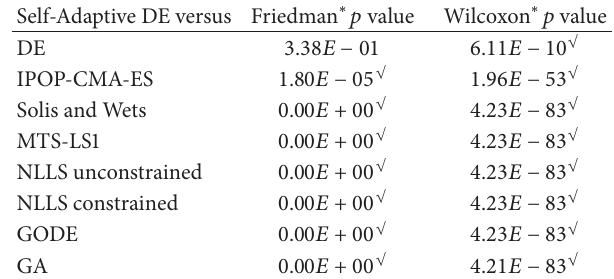
Table 16: Corrected 𝑝 values according to Holm’s method (Self- Adaptive DE is the control algorithm) for the 2-term exponential